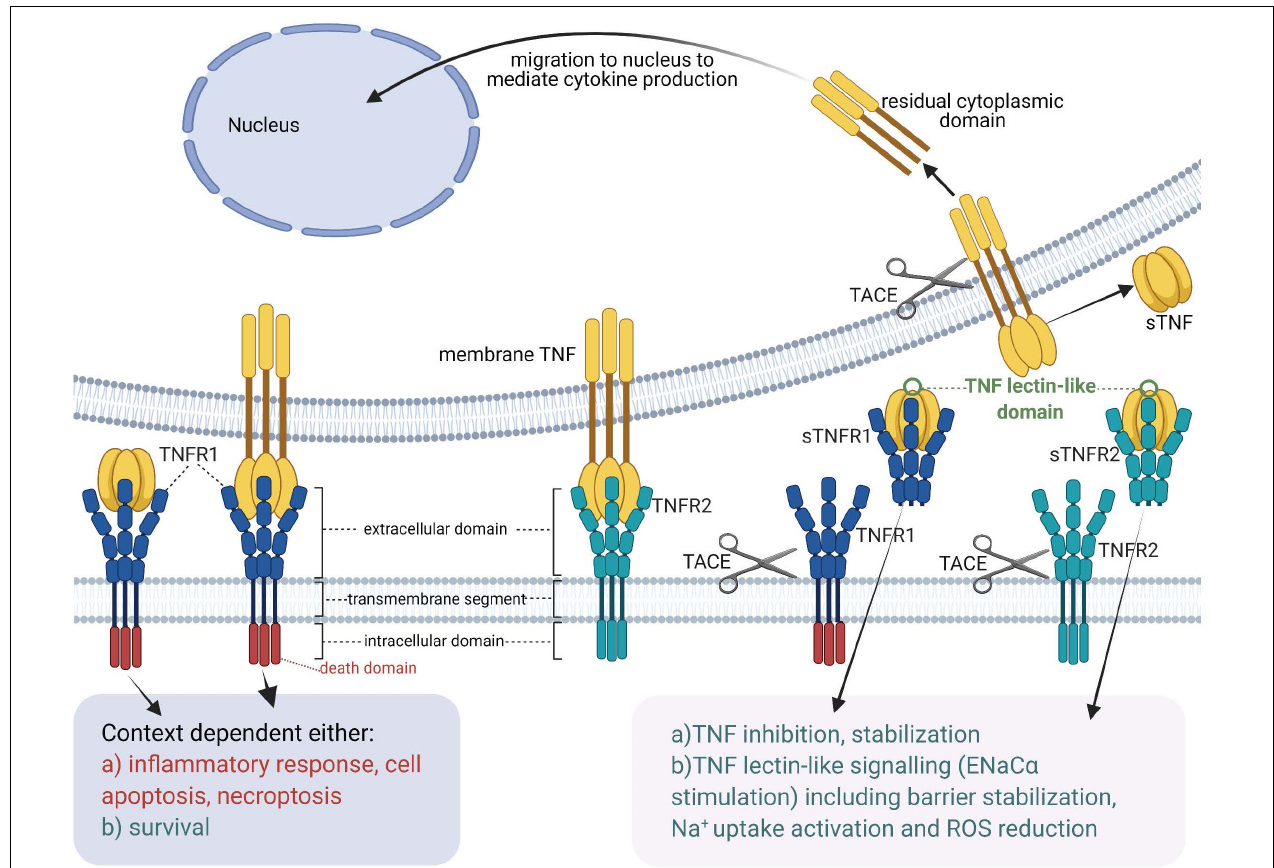
FIGURE 1 | Tumor necrosis factor receptors, TNF ligands, TNF-soluble TNF receptor complexes and TNF lectin-like activity [Adapted from Horiuchi et al. (2010)]. sTNF, soluble TNF; mTNF, transmembrane TNF; sTNFR, soluble TNF receptor; TACE, TNF Alpha Converting Enzyme; TNF, tumor necrosis factor; TNFR1, membrane-associated TNF receptor 1; TNFR2, membrane-associated TNF receptor